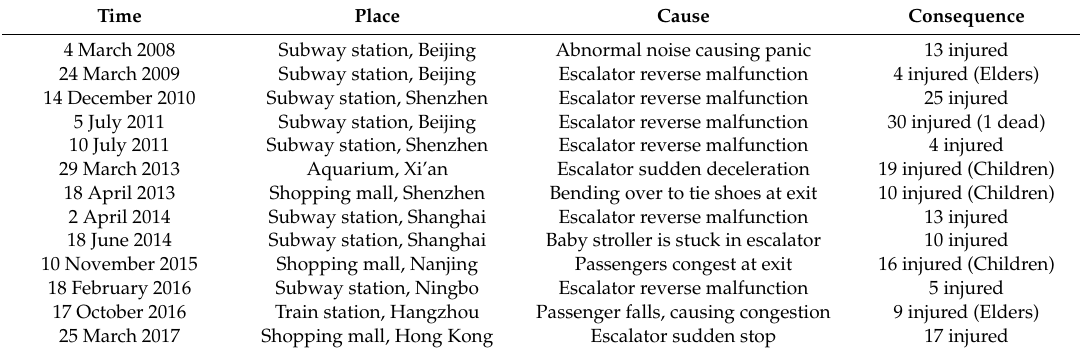
Table 1. Part of serious escalator-related incidents (EIs) in